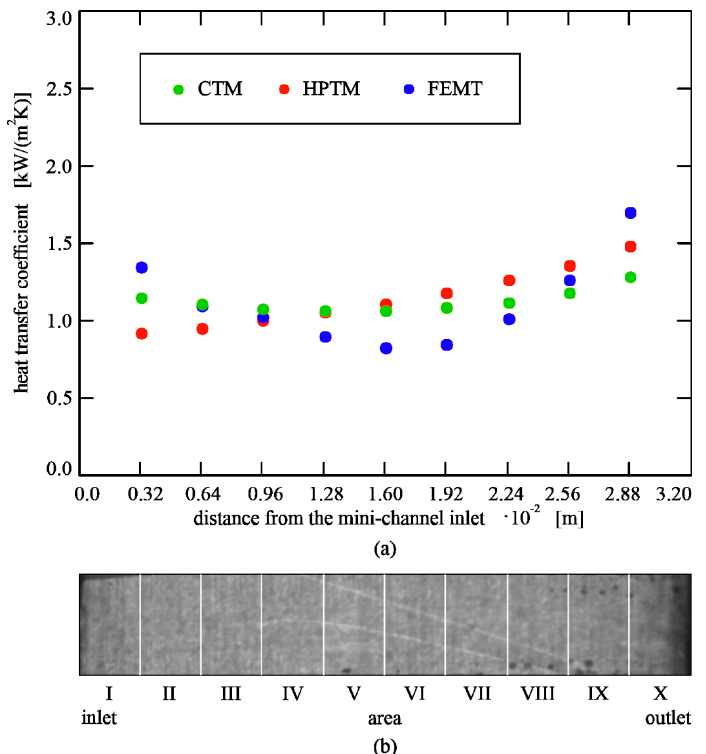
Figure 7. ( a ) Heat transfer coefficient versus distance from the mini-channel inlet, ( b ) two-phase flow pattern, t = 380 s, other experimental parameters listed in Table 1.